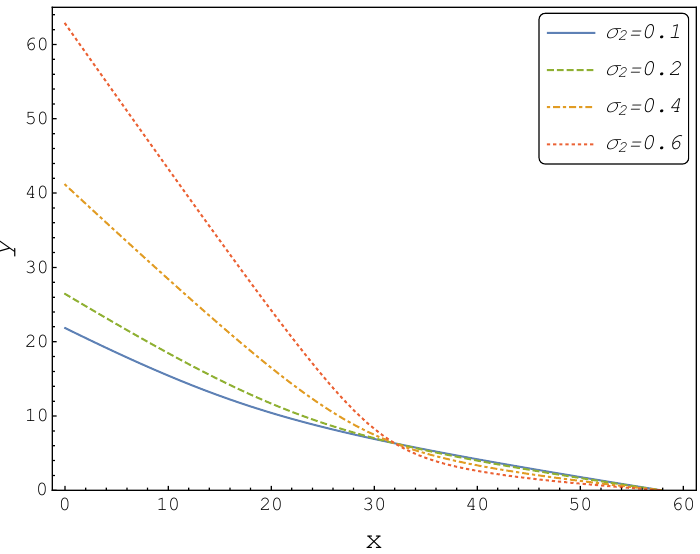
Figure 1. The threshold boundaries, ˆ b , for the following set of parameter values: σ 1 = 0.2, α 1 = 0.02, α 2 = 0.02, r = 0.1, ρ = 0, Q 1 = 5, Q 2 = 10, I = 2000 and different values of σ 2